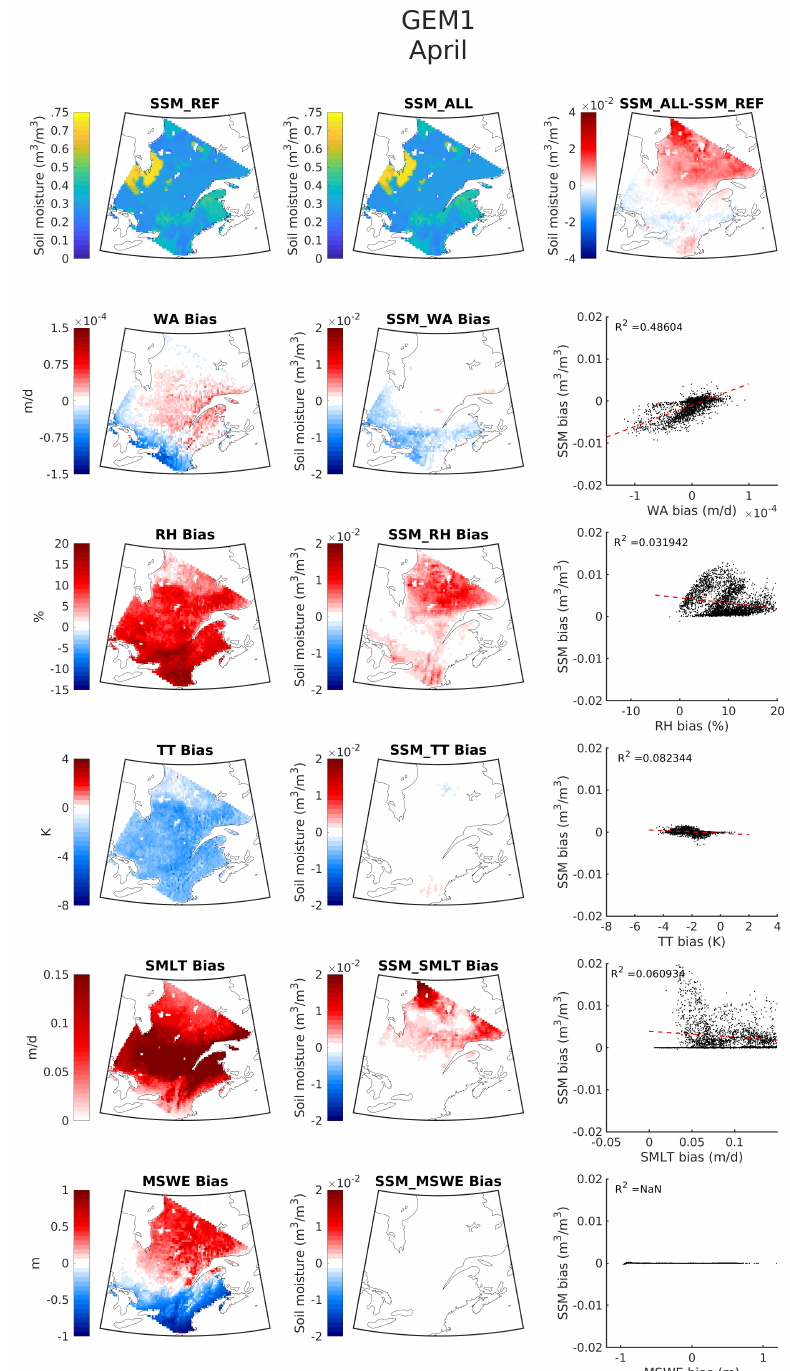
Figure 9. RF2 emulated SSM when using ERA5 predictors ( top left panel), GEM1 predictors ( top center panel) and their difference ( top right panel) for the month of April in the 1989 − 2020 period. GEM1 predictor biases when compared with ERA5 ( left column). SSM biases when replacing ERA5 climate predictors with those from GEM1 in RF2. Scatter plots of SSM bias against predictor bias are presented in the right